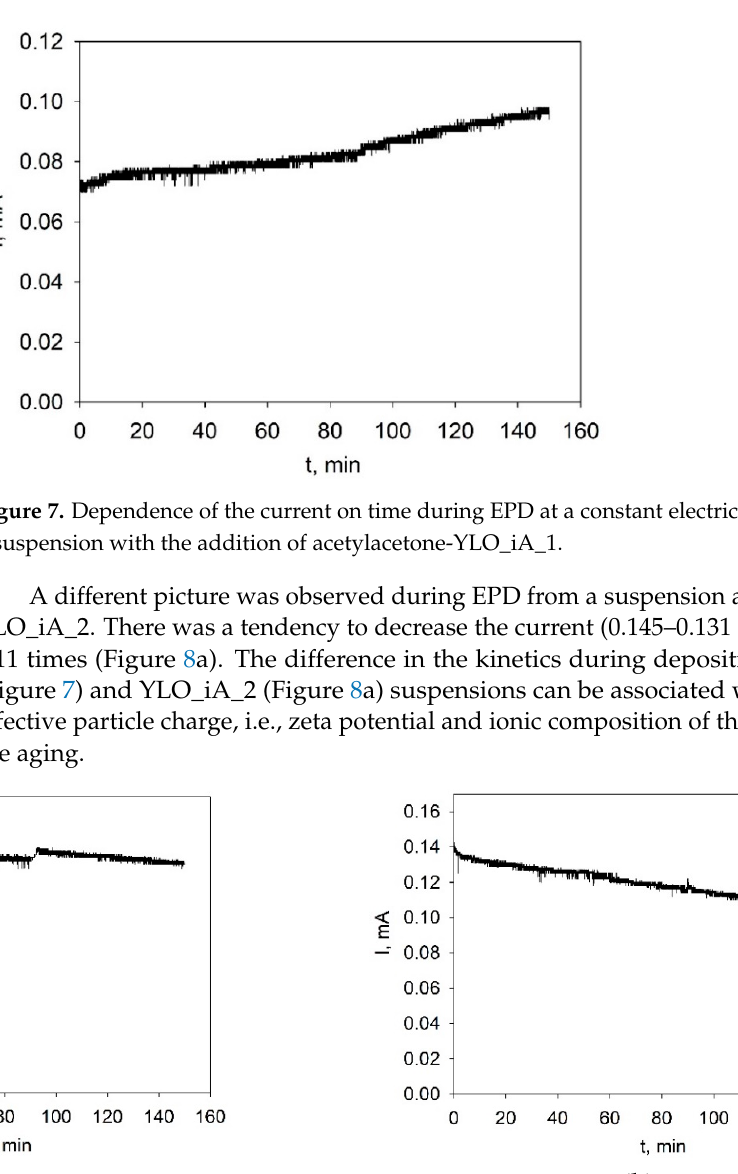
Figure 9. Dry compact obtained by vertical EPD from YLO_iA_1 suspension: ( a )–at the beginning of the drying process in the cell; ( b ) dry compact. Table 2. Suspensions, EPD parameters, size and density of the green bodies. Suspension